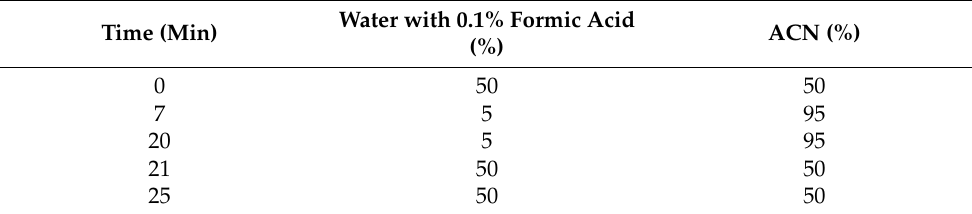
Table 1. Parameters of the optimized gradient method for semi-preparative HPLC. Water with 0.1% Formic Acid ACN (%) Time (Min) (%) 0 50 50 7 5 95 20 95 21 50 25 50